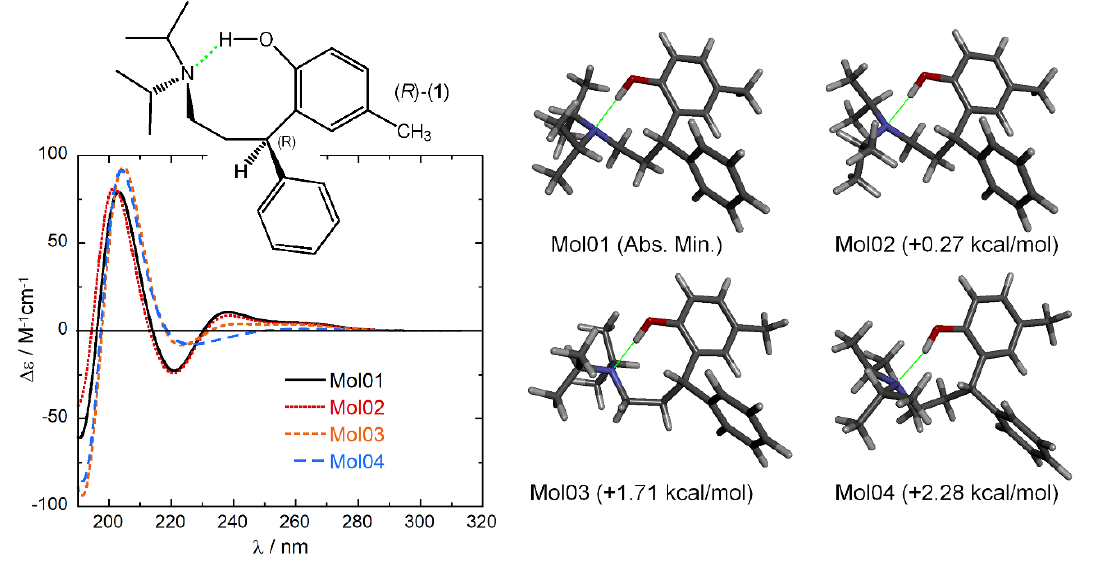
Figure 4. ECD spectra calculated at CAM-B3LYP/def2-TZVP level for the first 4 low-energy conformers of ( R )- 1 obtained after ω B97X-D/6-31+G(d) geometry optimizations (shown on the right, with relative energies). Spectra plotted as sum of Gaussians with σ = 0.3 eV, shifted by +13 nm. The molecular diagram emphasizes the formation of the intramolecular hydrogen bond (green).